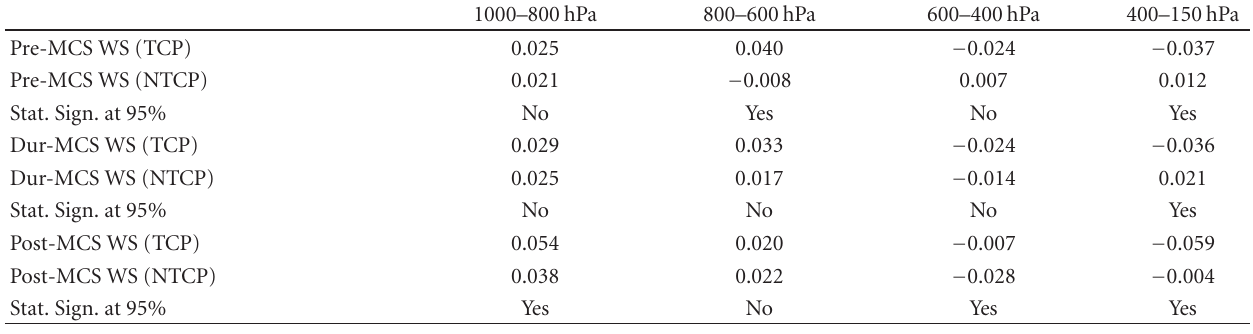
Table 6: Mean wind speed (WS) shear (ms − 1 hPa − 1 ) for four levels within the atmospheric column are provided. Values are shown for the means of each system type for pre-MCS, during MCS, and post-MCS wind profiles along with the statistical significance based on a Student’s t -test.